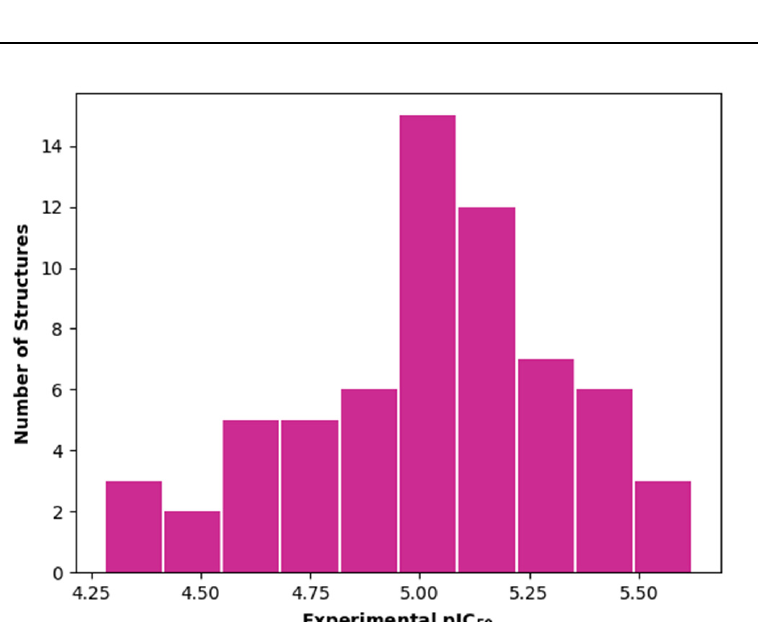
deviation (SD) for the training set, and external validation parameters, i.e., the predicted